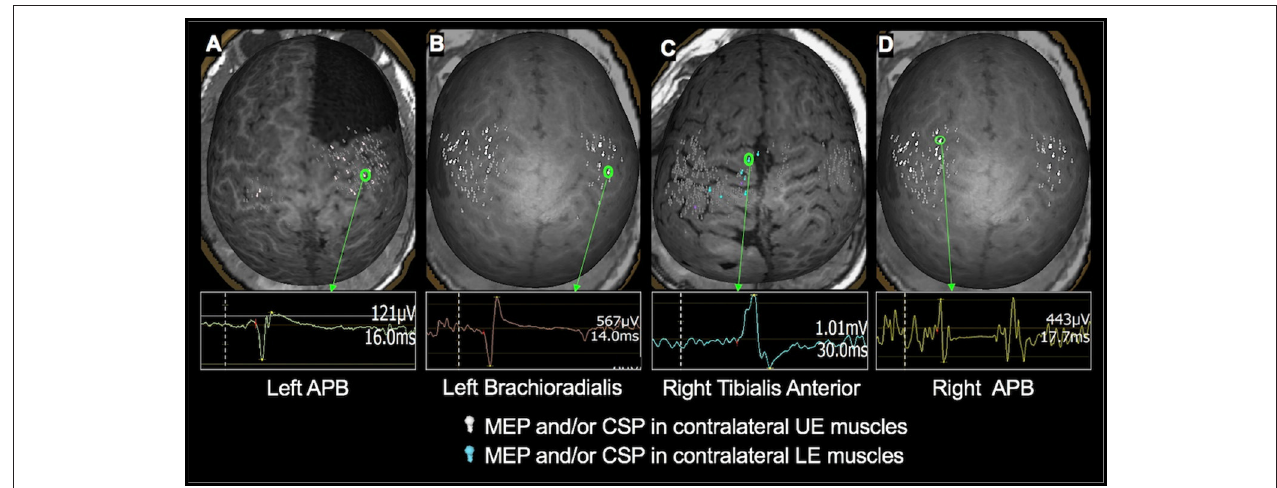
FIGURE 2 | Examples of TMS-evoked MEPs and CSP in children under 3 years of age. (A) : A 2.4-year-old male with right frontal lobe cortical dysplasia status post resection. MEP in the left APB muscle having an amplitude of 121 µ V and a latency of 16ms was evoked when TMS was applied to the right precentral gyrus. (B) An 18-month-old female with history of left hemisphere perinatal stroke involving left temporal lobe and subsequent infantile spasms demonstrating MEP evoked in the left brachioradialis muscle with an amplitude of 567 µ V and a latency of 14ms following TMS applied to the right precentral gyrus. (C) 1.7-year-old female with TSC- 2 demonstrating the MEP elicited in the right tibialis anterior muscle having an amplitude of 1.01mV and a latency of 30ms when TMS was applied to the left medial frontal lobe. (D) An 18-month-old female with history of left hemisphere perinatal stroke involving left temporal lobe and subsequent infantile spasms demonstrating CSP evoked in the right APB muscle following TMS applied to the left precentral gyrus. The left hemisphere is on the left side of the